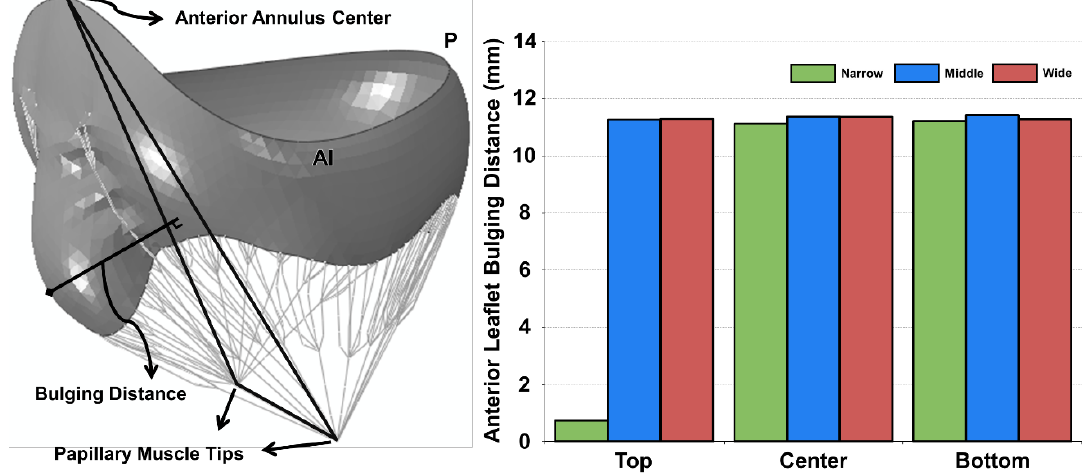
Figure 7. Anterior leaflet bulging distance with respect to alteration of the SC insertion location during the diastolic phase. The shortest distance is found in the narrow – top MV model. A — anterior; Al — anterolateral; P — posterior.